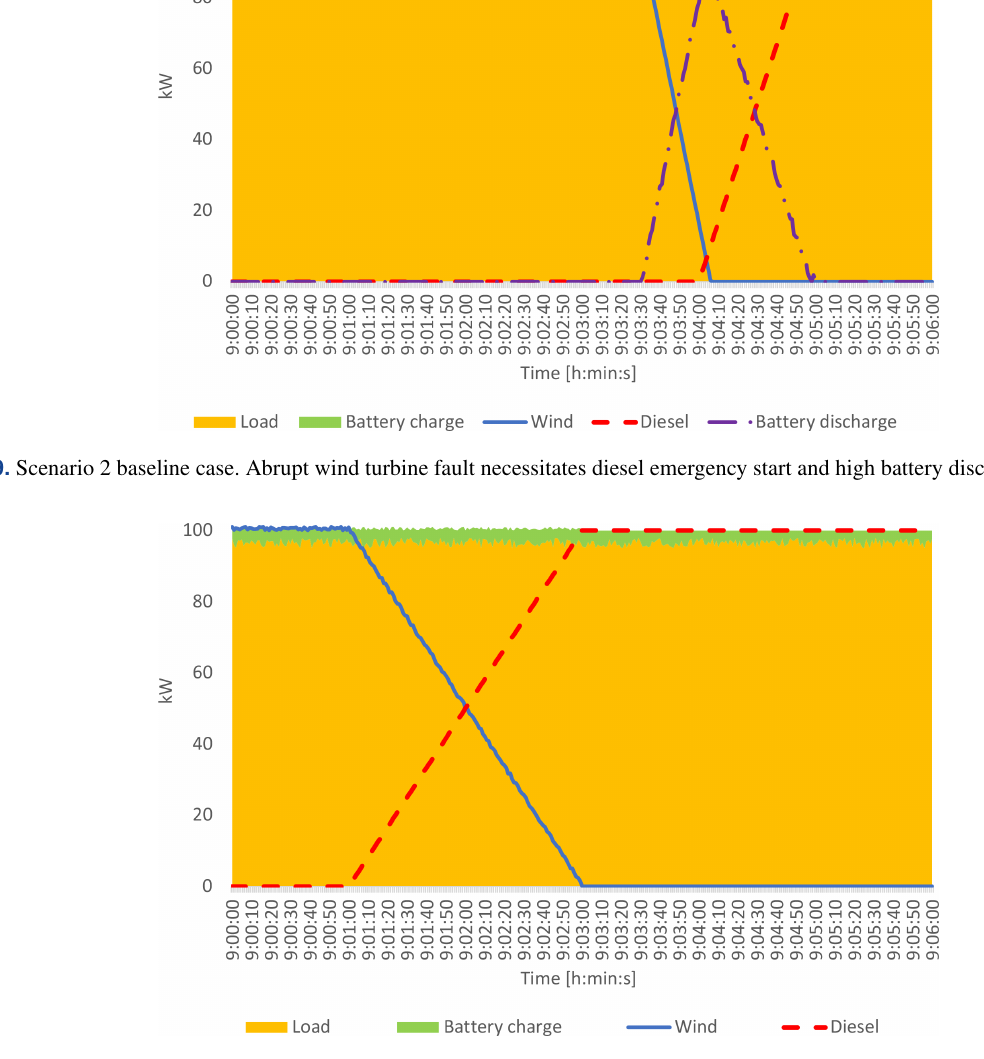
Figure 10. Scenario 2 FIRC case. Anticipated wind turbine fault allows for a seamless transition from wind to diesel generation, without battery